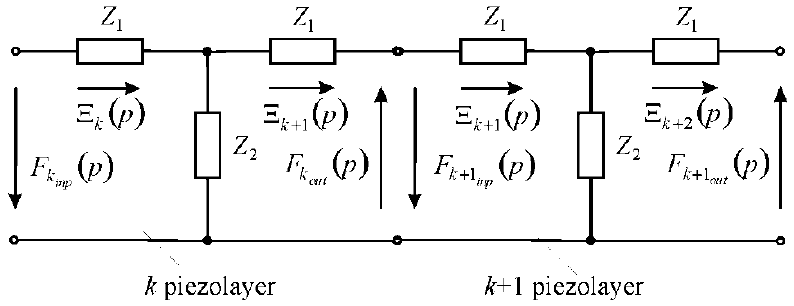
Figure 3. Circuit of the multilayer piezoactuator with quadripoles for the k and k + 1 piezolayers.